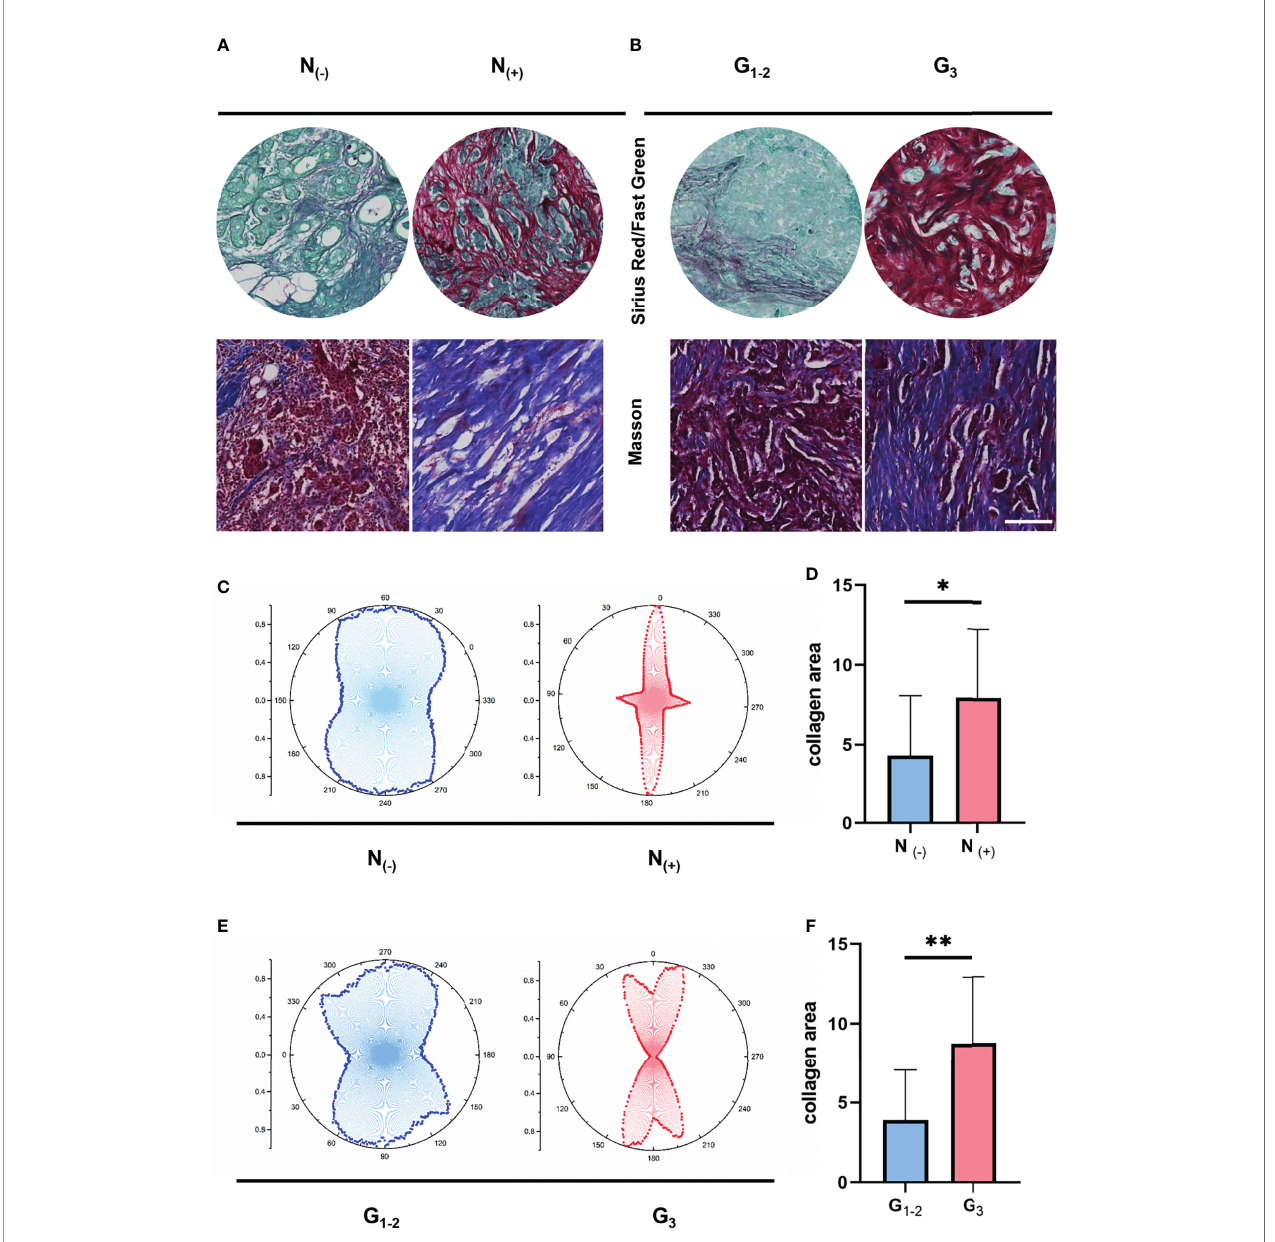
FIGURE 5 | ECM characteristics are associated with breast tumor progression and metastasis in clinical samples. (A) Masson ’ s trichrome and Sirius red/Fast Green staining between different nodal status. (B) Masson ’ s trichrome and Sirius red/Fast Green staining between different pathological stages. (C) Orientation distribution of collagen fi brils between different nodal status. (D) Area of collagen fi brils between different nodal status. (E) Orientation distribution of collagen fi brils between different pathological stages. (F) Area of collagen fi brils different pathological stages. (scale bar, 100 m m). * P < 0.05; ** P <